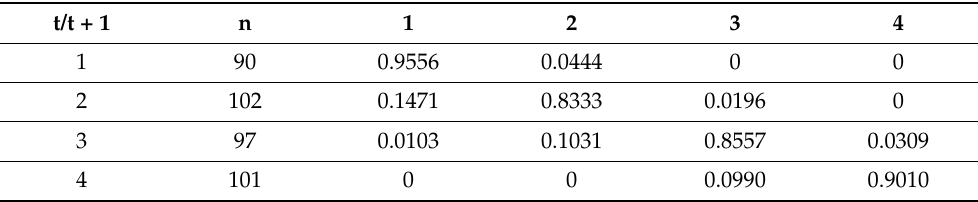
Table 2. Traditional Markov probability transfer matrix of ecological well-being performance in China. t/t + 1 n